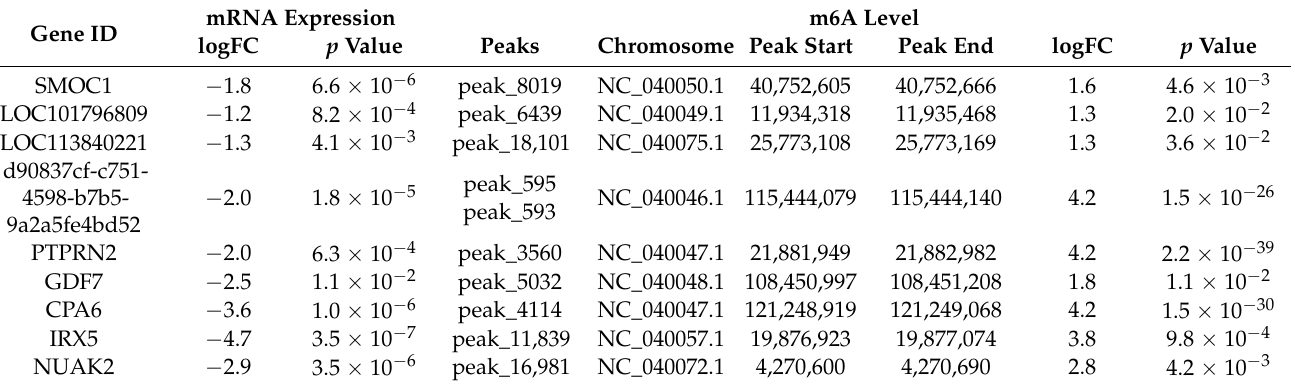
Table 4. List of hyper-down methylated genes that were significantly different between E19 and E13.